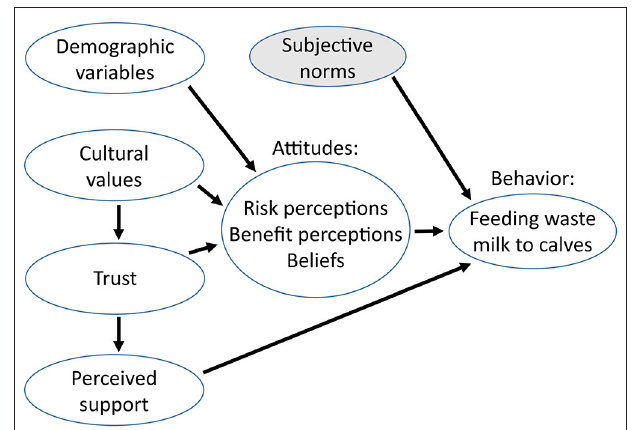
FIGURE 1 | Diagram of the interrelated concepts investigated in relation to the feeding of waste milk containing antimicrobial residues to calves. Subjective norms were not included in the final analyses due to missing